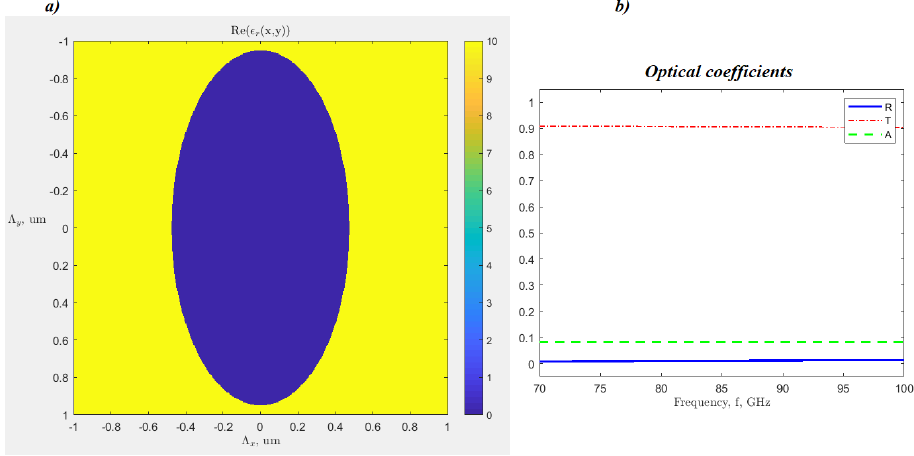
Fig. 2. Metallized surface consisting of periodically arranged elliptical conductive particles: a – unit cell dielectric constant plot, b – optical coefficients